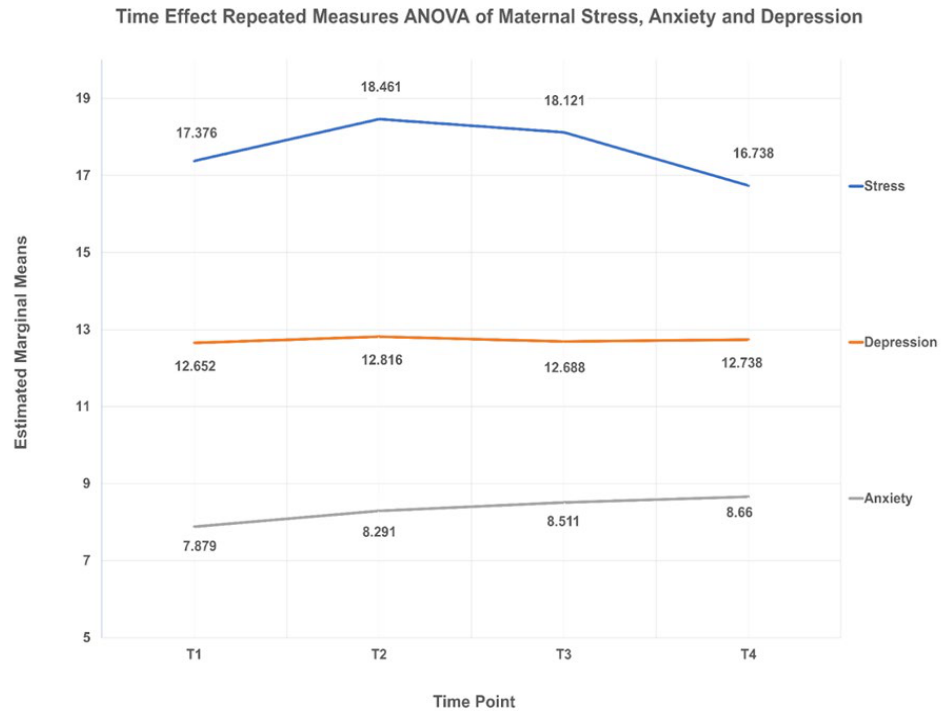
Figure 1. Time effect repeated measures ANOVA of maternal stress, anxiety, and depression. Note: (1) A stress score between 14 and 26 indicates moderate stress, (2) An anxiety score between 0 and 7 and between 8 and 10 indicate low and moderate levels of anxiety, respectively, (3) A depression score between 11 and 21 indicate high levels of depression.